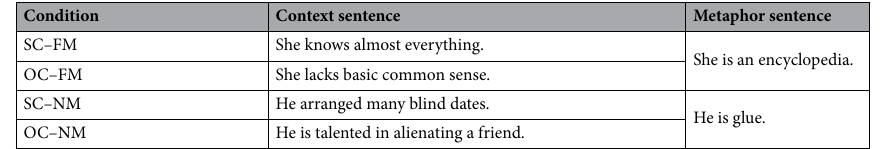
Table 5. Examples of context and metaphor sentences. SC–FM supporting context with familiar metaphor, OC–FM opposing context with familiar metaphor, SC–NM supporting context with novel metaphor, OC–NM opposing context with novel